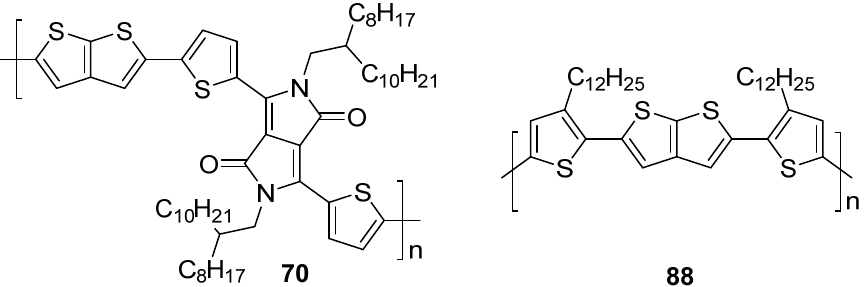
Figure 13. In both cases, the bicyclic TT scaffold was utilized as a part of the π -conjugated polymeric backbone featuring the p type semiconductivity. Derivative 88 was deposited along the silane self-assembled monolayers, while a combination with octadecyltri- chlorosilane brought the highest hole mobility (Table 9).